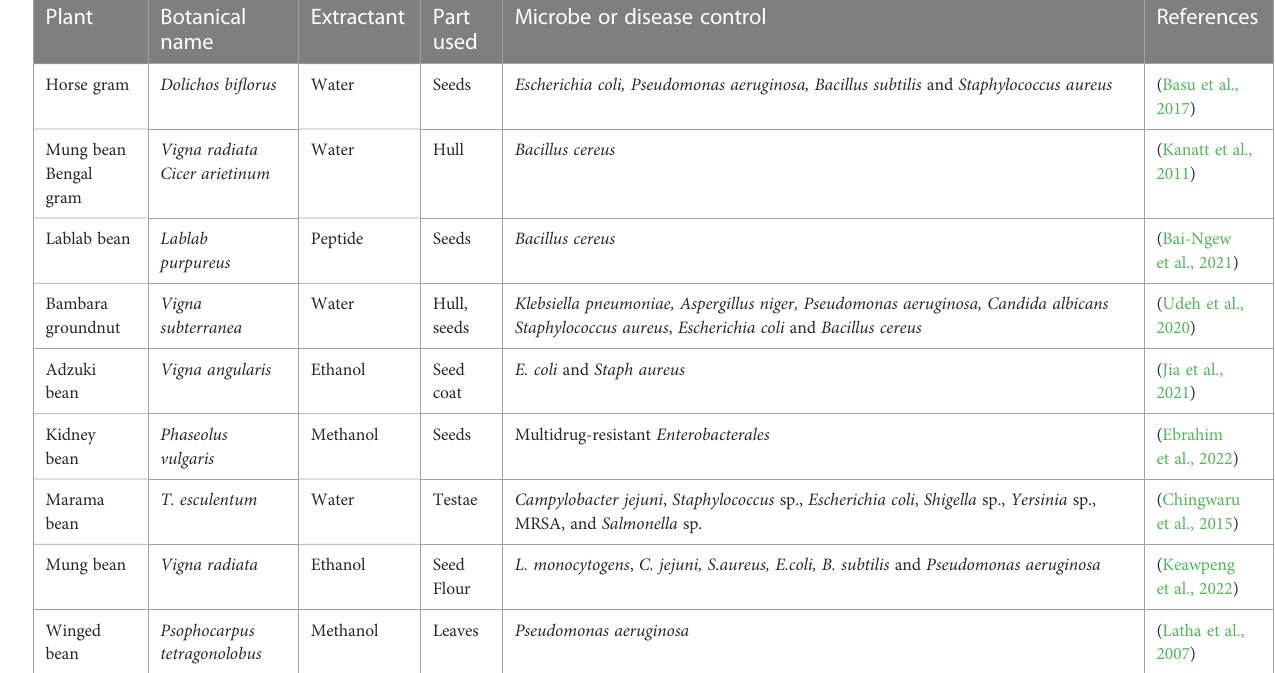
TABLE 5 Antimicrobial properties of underutilized legumes. Plant Botanical